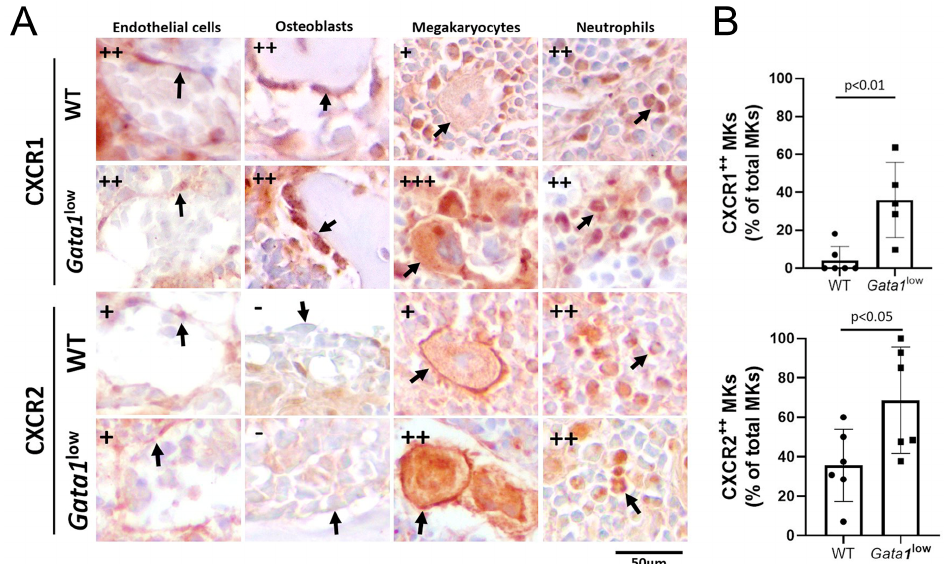
Figure 6. Malignant megakaryocytes express great levels of CXCR1 and CXCR2 . ( A ) Representative sections from the bone marrow of wild-type and Gata1 low littermates immunostained with antibodies per CXCR1 and CXCR2, showing the level of these receptors in endothelial cells, osteoblasts, megakaryocytes, and neutrophils (indicated with arrows). Semiquantitative estimates ( − , +, or ++) of the intensity of the staining in the different cells are provided on the top left. Original magnification 40 × . Representative sections stained only with the secondary antibodies, are shown in Figure S6 (Supplementary Materials), as negative controls. ( B ) Percentage of megakaryocytes expressing high levels of CXCR1 and CXCR2. The proinflammatory cytokines were quantified as described in Figure S2B (Supplementary Materials) on five randomly selected areas per femur from three–four mice per experimental group. Statistical analysis was performed by t -test, and statistically significant p values among groups are indicated within the panels. Abbreviations: CXCR1 and 2: CXC motif chemokine receptor 1 and 2; WT: wild-type; MKs: megakaryocytes.